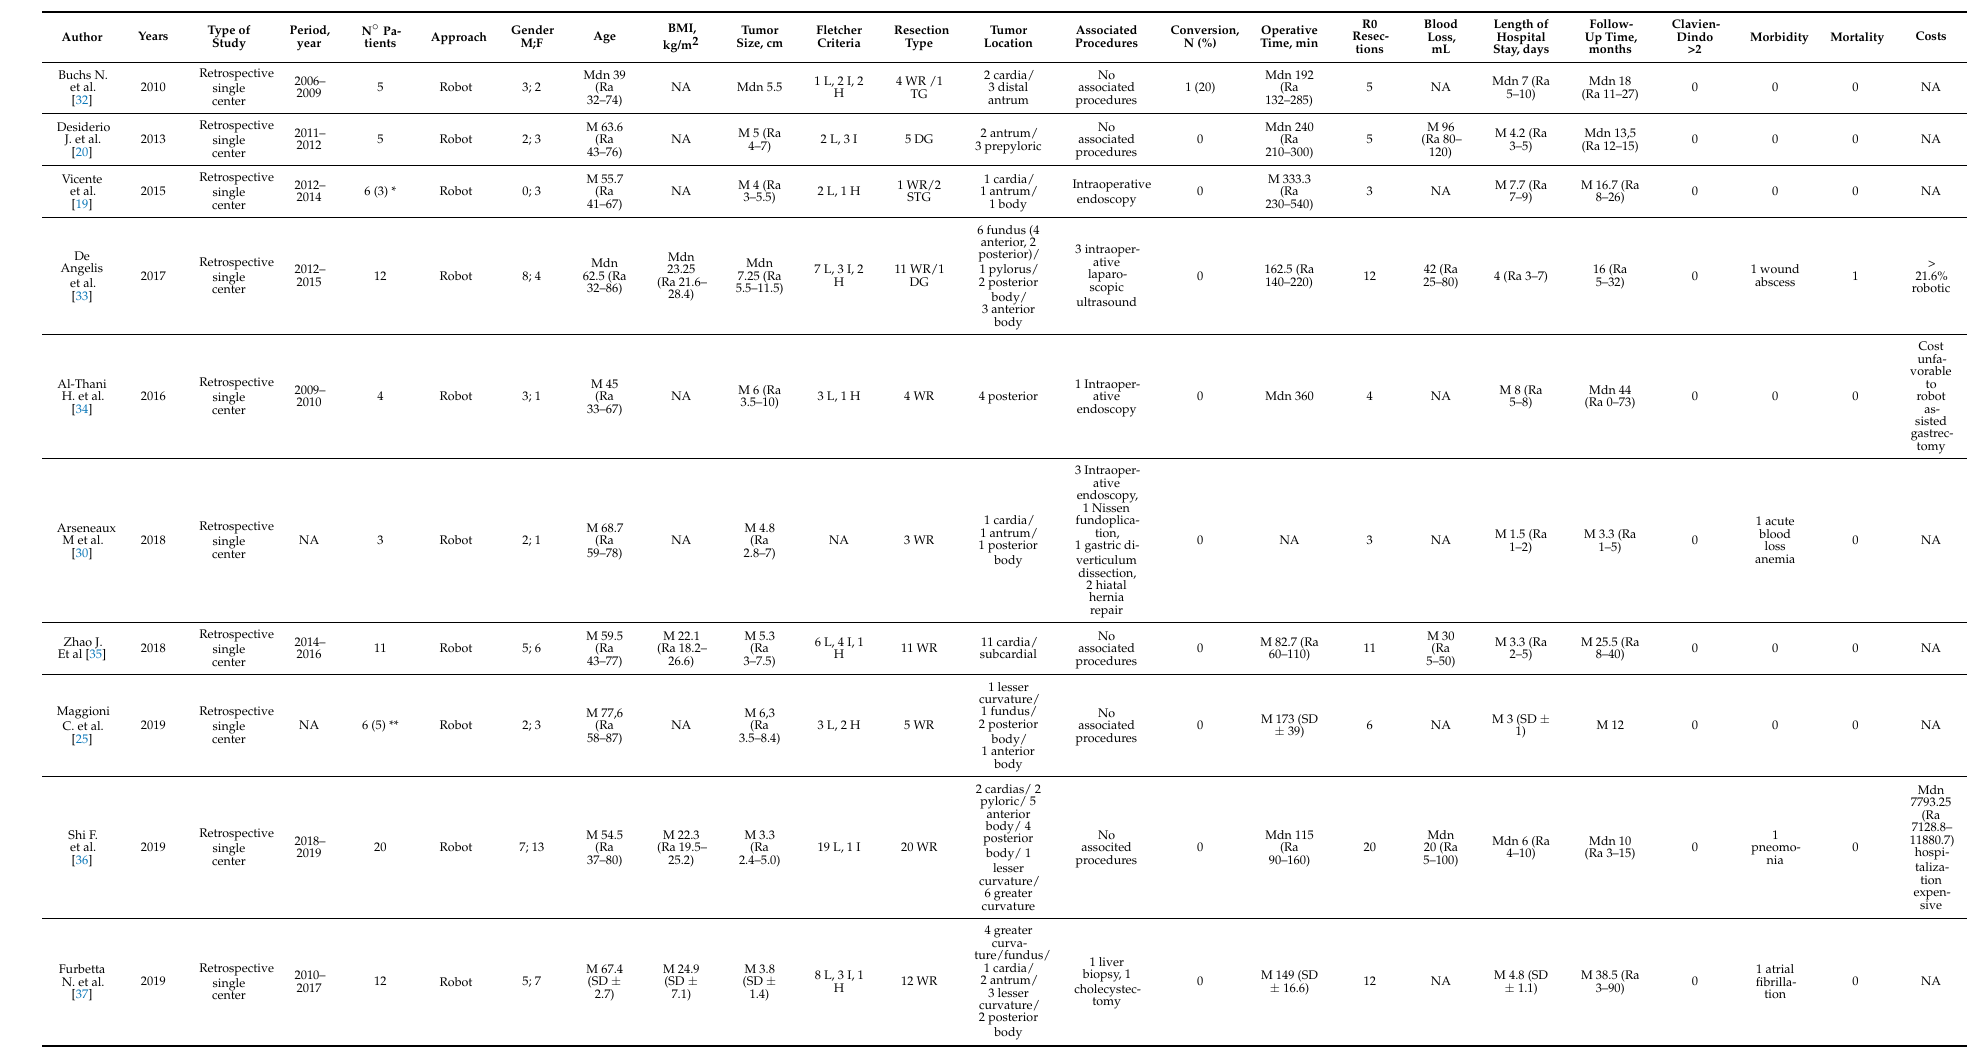
Table 4. Studies on robotic gastro-intestinal stromal tumor (GIST) resections: study, patient, tumor, and peri-operative